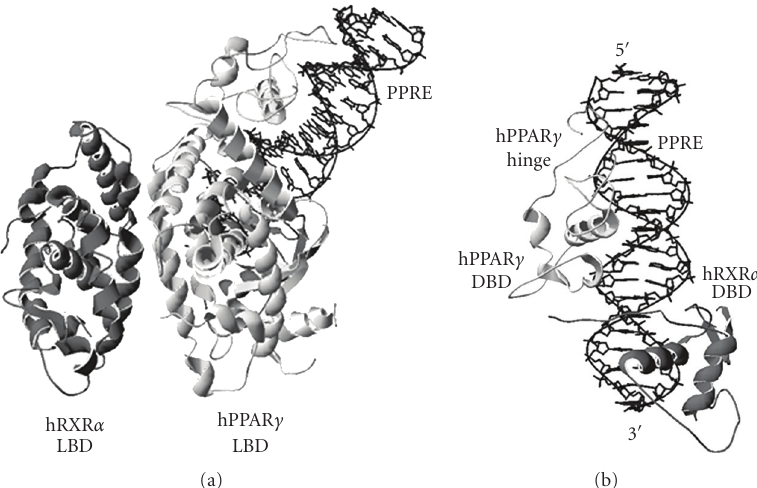
Figure 1: (a) Ribbon drawing of the human RXR α /human PPAR γ heterodimer on PPRE (PBD 3E00). (b) Ribbon drawing of the heterodimer/DNA complex showing only the PPRE and the DBDs of RXR α and PPAR γ . The RXR and PPAR monomers are colored in dark and light grey, respectively. The PPRE is colored in black; the 5 (cid:2) and 3 (cid:2) ends are also labeled.